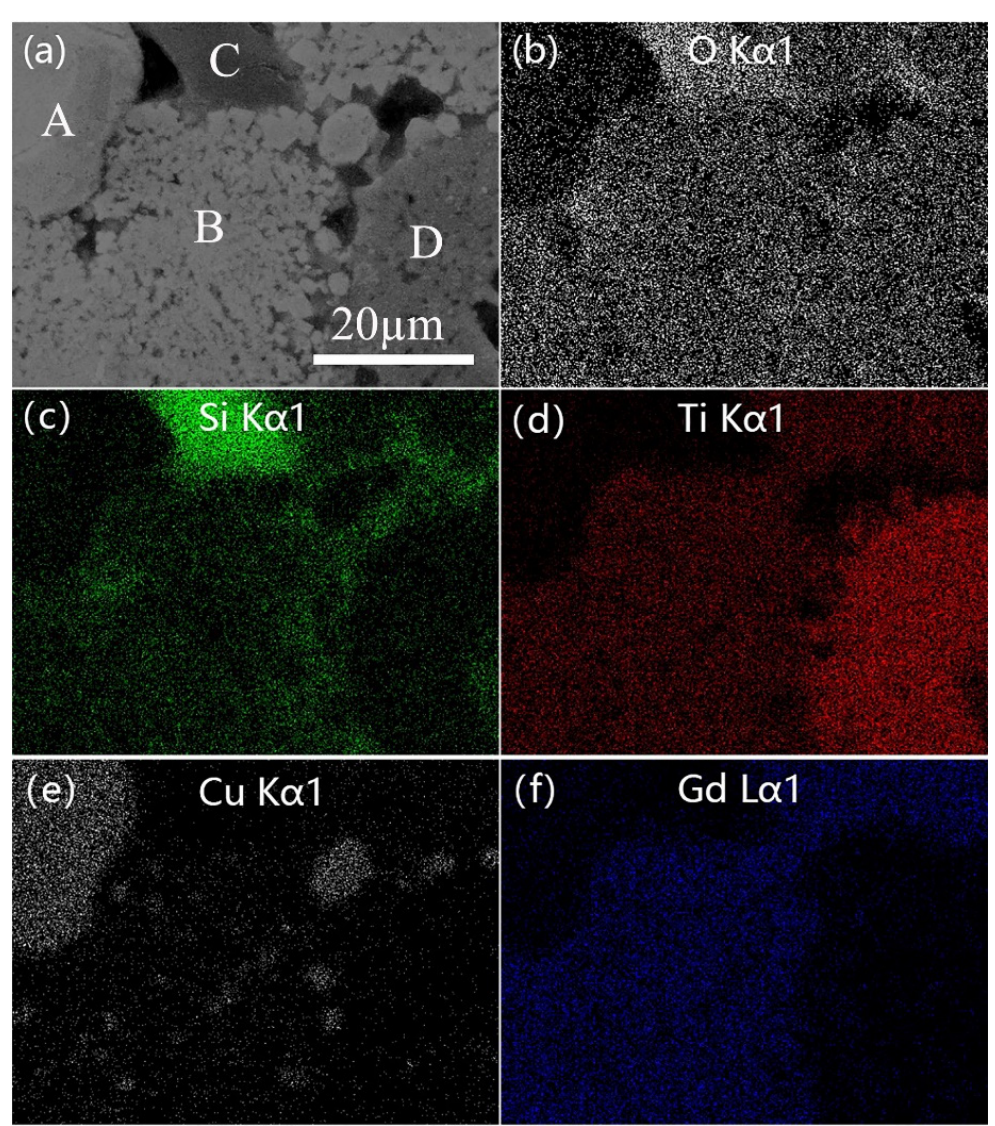
Figure 5. ( a ) SEM image of Cu-20 specimen, and element mapping images of ( b ) O, ( c ) Si, ( d ) Ti, ( e ) Cu, ( f ) Gd.